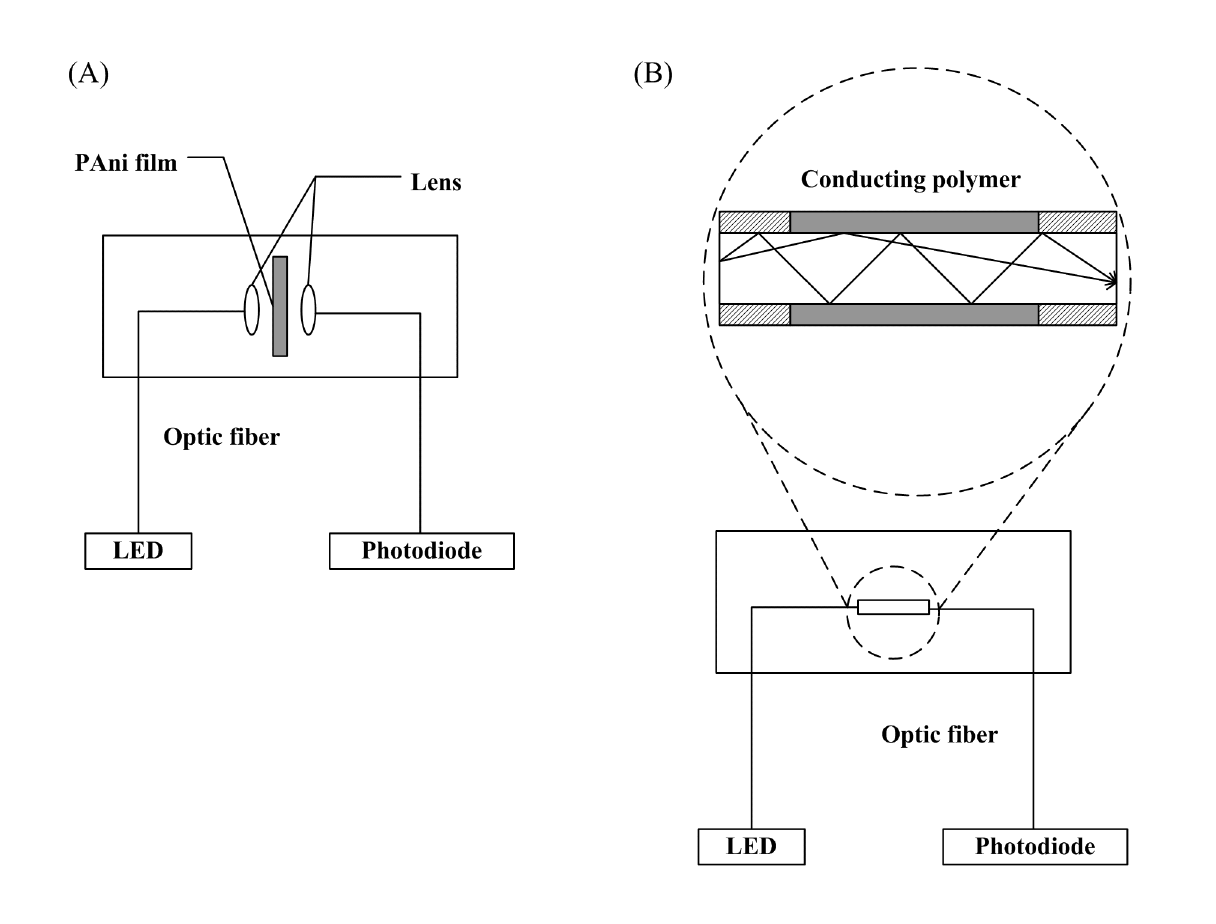
Figure 8. Configuration of two typical optical sensors using optical